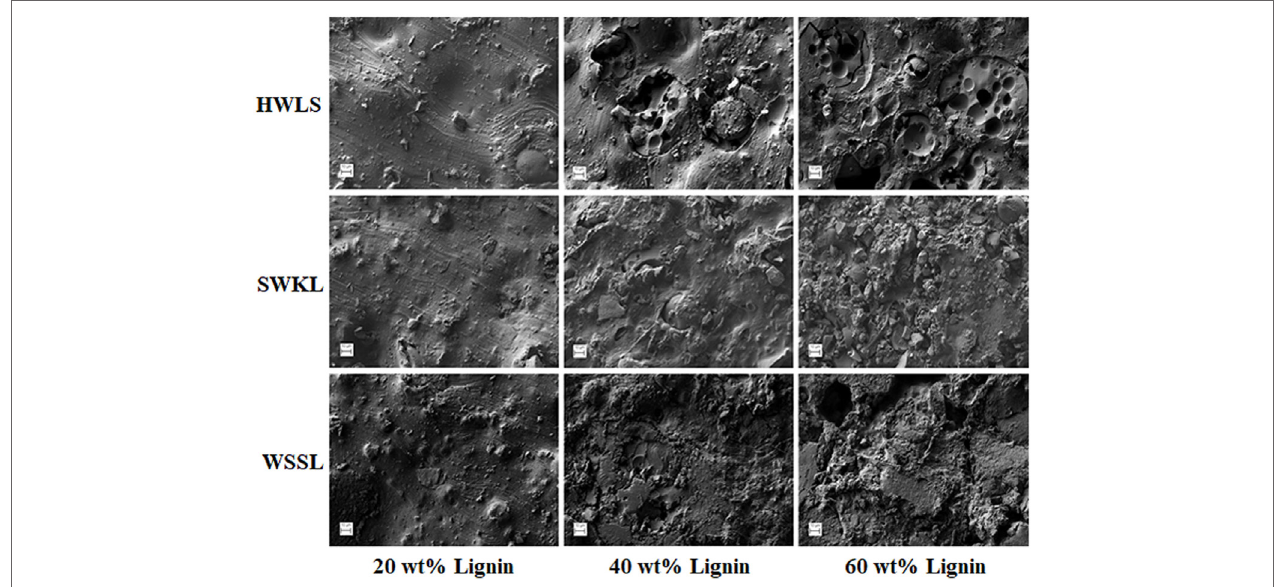
FigUre 10 | Scanning electron microscope images of lignin-based polyurethane samples with 20, 40, and 60 wt% lignin loading.